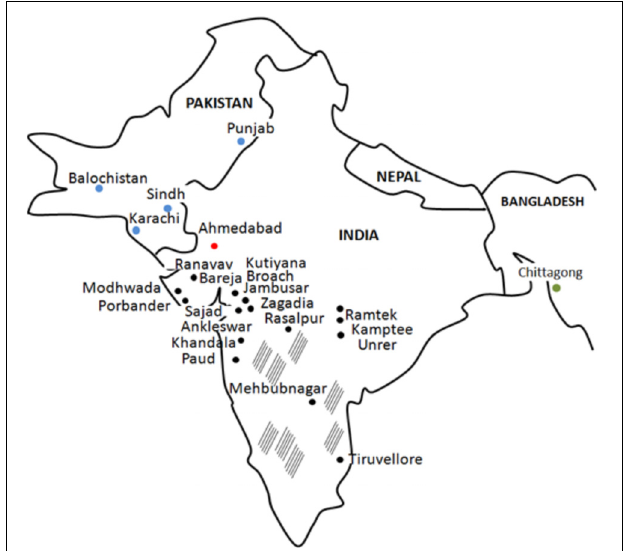
FIGURE 1 | ZIKV cases in India (1954 and 2016 years), Pakistan (1983 year) and Bangladesh (2016 year). Black, India sites from 1954 study; Red, India sites from 2016 study; Blue, Pakistan sites from 1983 study; Green, Bangladesh from 2016 study; striped areas, sites tested negative for ZIKV antibody in 1954